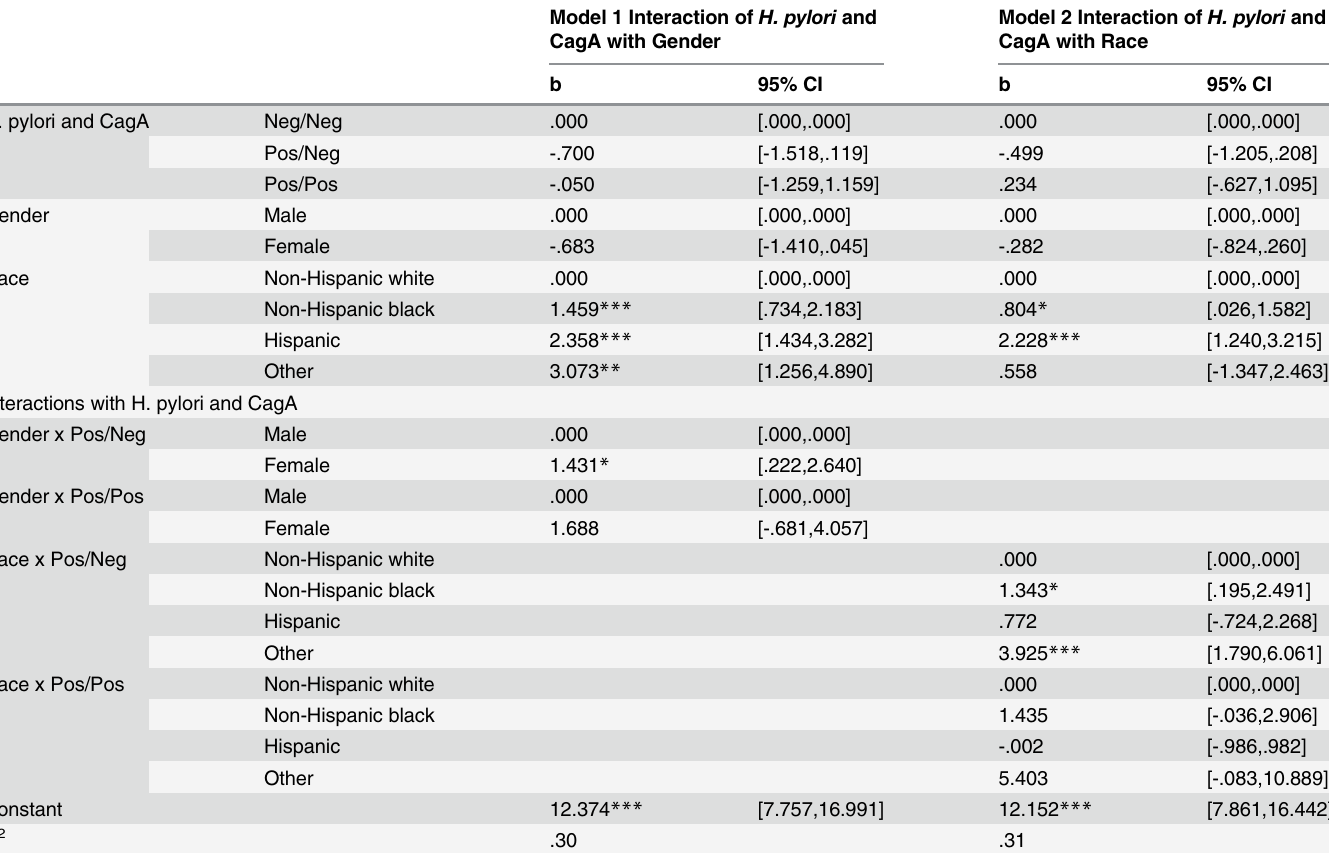
Table 5. Analysis of the Serial Digit Learning Test with Interactions of H. pylori and CagA in US 21 to 59 Year-Olds, NHANES III (1988 – 1994): Unstandardized Coef fi cients [95%CI] from Weighted OLS